Question: What kind of plot is shown here?
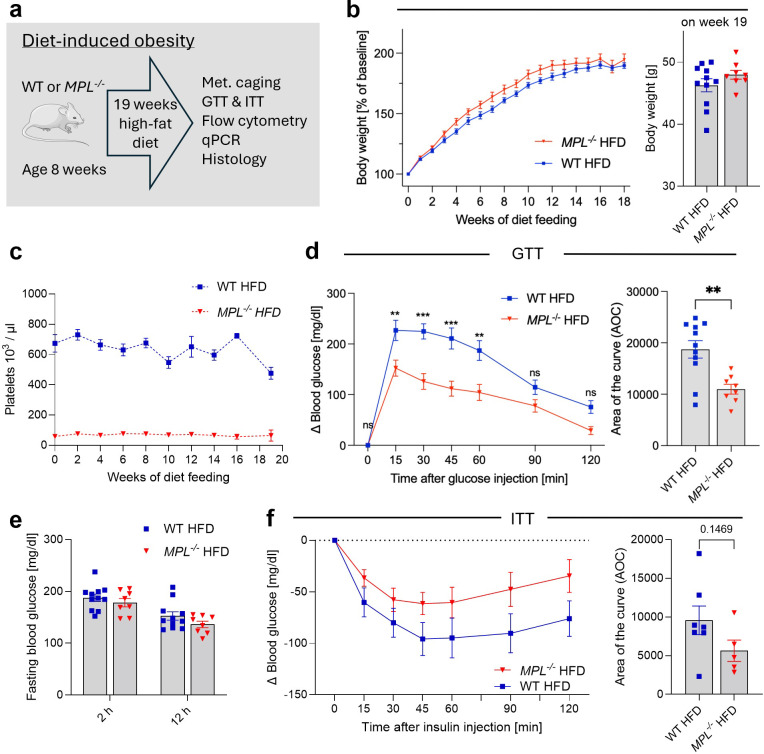
Answer: line